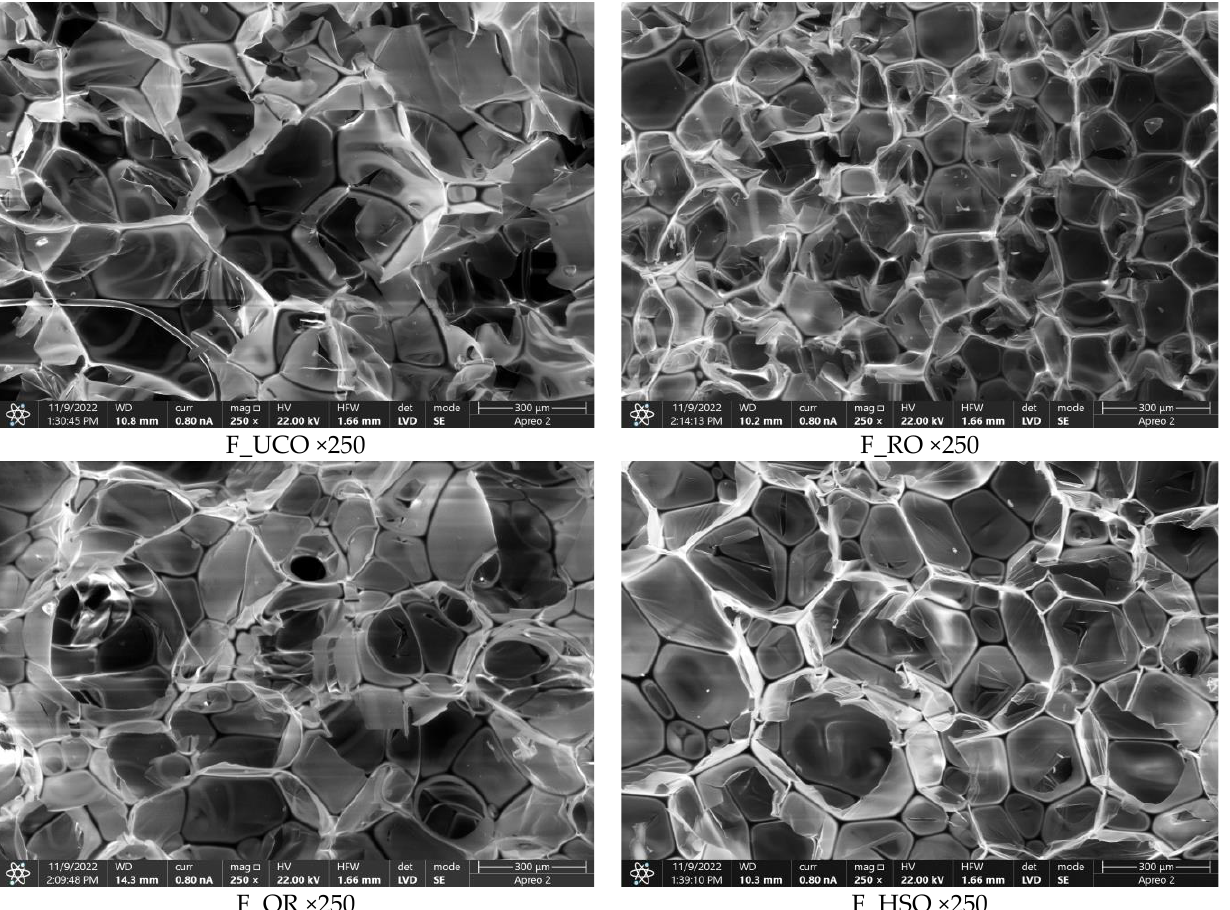
Figure 8. SEM images of the polyurethane foams at a magnification of 250×.